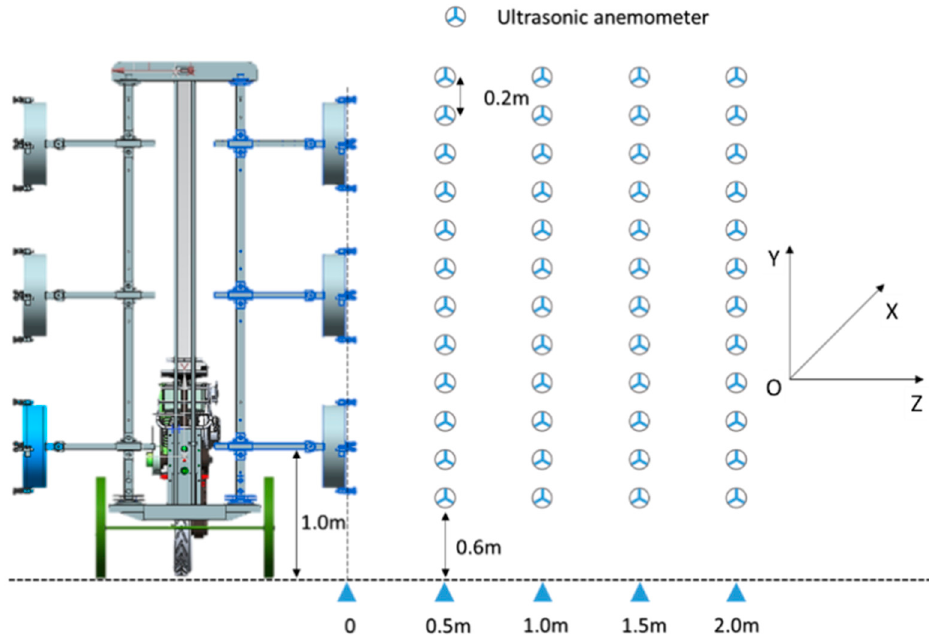
Figure 3. Layout of airflow pattern test of MAS in an open field. The X -axis represented the forward direction, the Y -axis represented the vertical direction, and the Z -axis represented the cross-row direction.